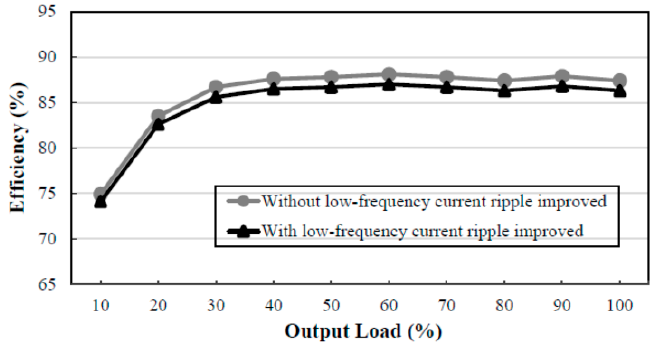
Energies 2020 , 13 , x FOR PEER REVIEW ffi ciency versus output load under 110 V input voltage. Figure 11. Curve of efficiency versus output load under 110 V input voltage. Figure 11. Curve of e